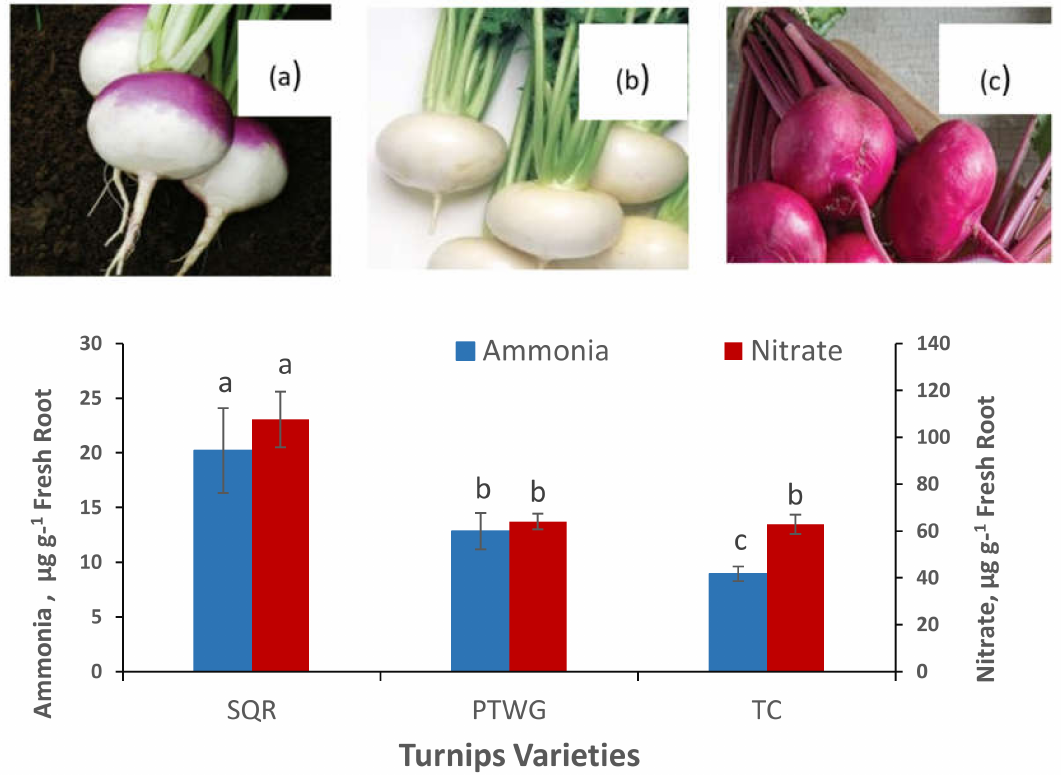
Figure 1. Variability in root morphology of three varieties of turnips ( Brassica rapa) : ( a ) Purple Top White Globe (PTWG), ( b ) Tokyo Cross (TC), and ( c ) Scarlet Queen Red (SQR) (upper photo) and NH 3 and NO 3 concentrations ± std. error in their roots (lower graph), regardless of soil treatments. Standard errors having different letter indicate significant differences ( p ≤ 0.05). Statistical comparisons carried-out among varieties using Duncan’s multiple range